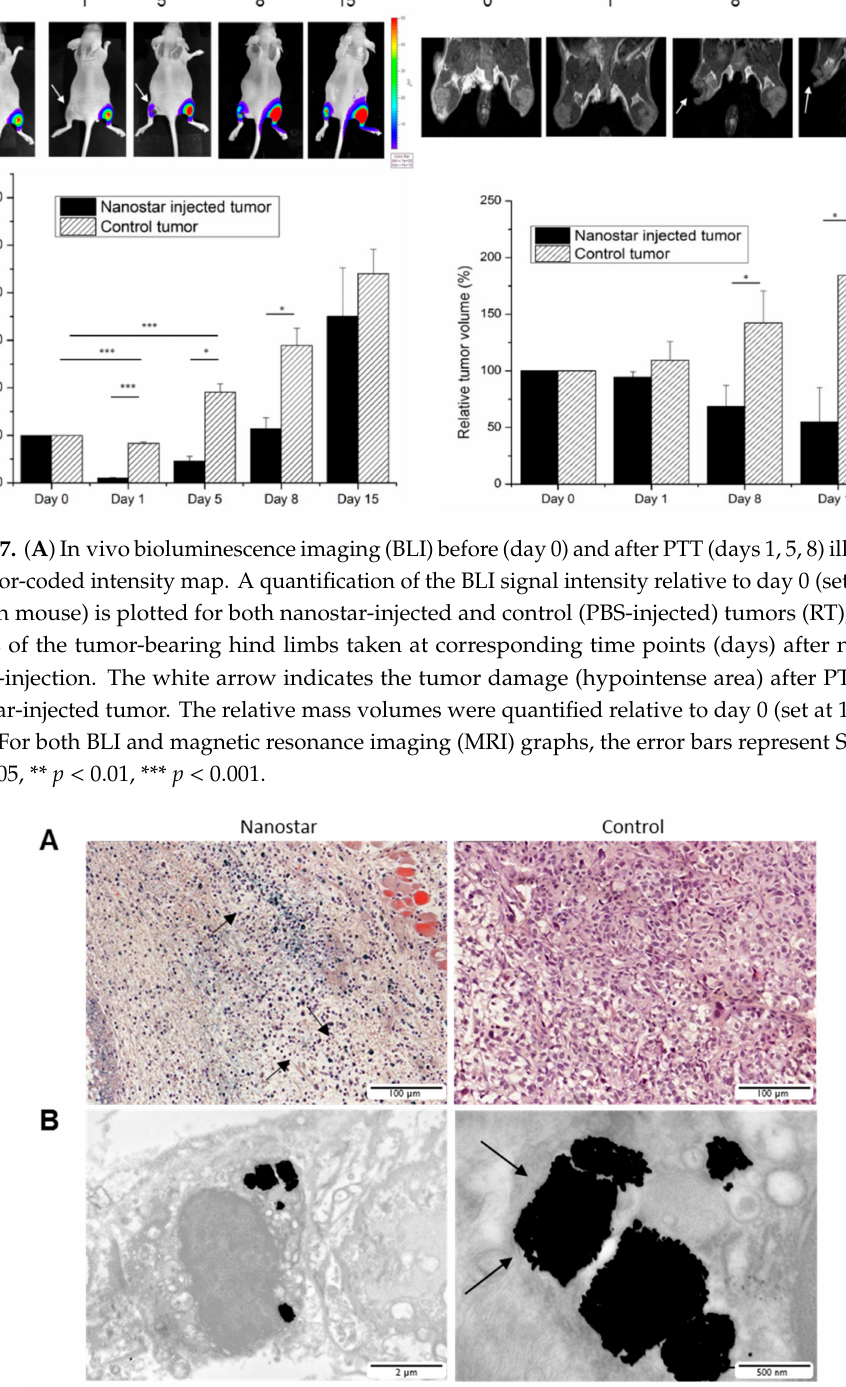
Figure 8. ( A ) Bright field microscopy images of control (right) and nanostar (left) injected hematoxylin and eosin (H&E) stained tumor sections. Defragmented nuclei of the tumor cells could be visualized after therapy. ( B ) Ex vivo TEM images of tumor cells that indicate the presence of NP clusters in endosomes. The right panel shows a zoomed section of these endosomes with vesicular structures